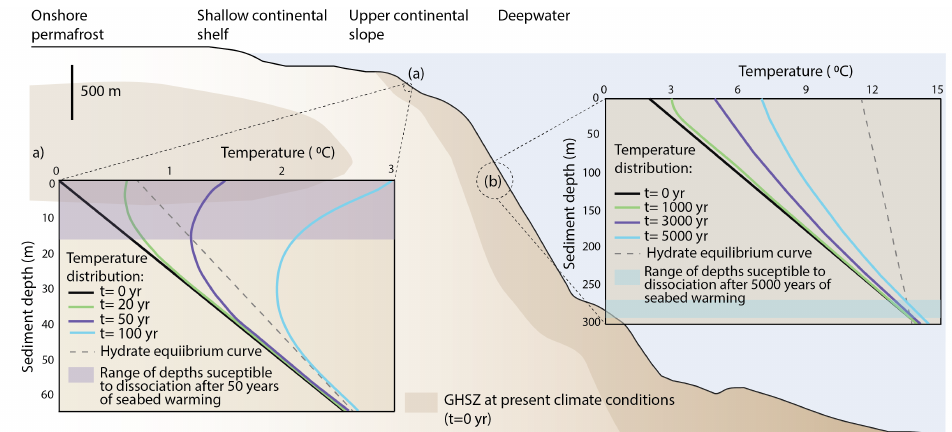
Figure 3. Schematic cross-section of a high-latitude ocean margin divided into four distinct zones where hydrate might be found. Insets show the response of hydrate reservoirs located at ( a ) 320 m water depth and exposed to a linear increase in bottom-water temperature of 3 ◦ C over 100 years, and ( b ) 1000 m water depth and exposed to linear bottom-water warming of 1.25 ◦ C over 5000 years. In shallow reservoirs ( a ), hydrate destabilisation likely initiates at the very top of the reservoir facilitating methane transport to the ocean (purple shaded area). For deep hydrates ( b ), destabilisation likely initiates at the base of the reservoir (blue shaded area) with a time delay with respect to the onset of warming at the seafloor caused by heat transport through the sediment column. Note that the original simulations assume that hydrate destabilise when the ambient temperature exceeds the equilibrium curve (grey dashed line), and ignore the heat absorbed during destabilisation. GHSZ: gas hydrate stability zone. Modified from